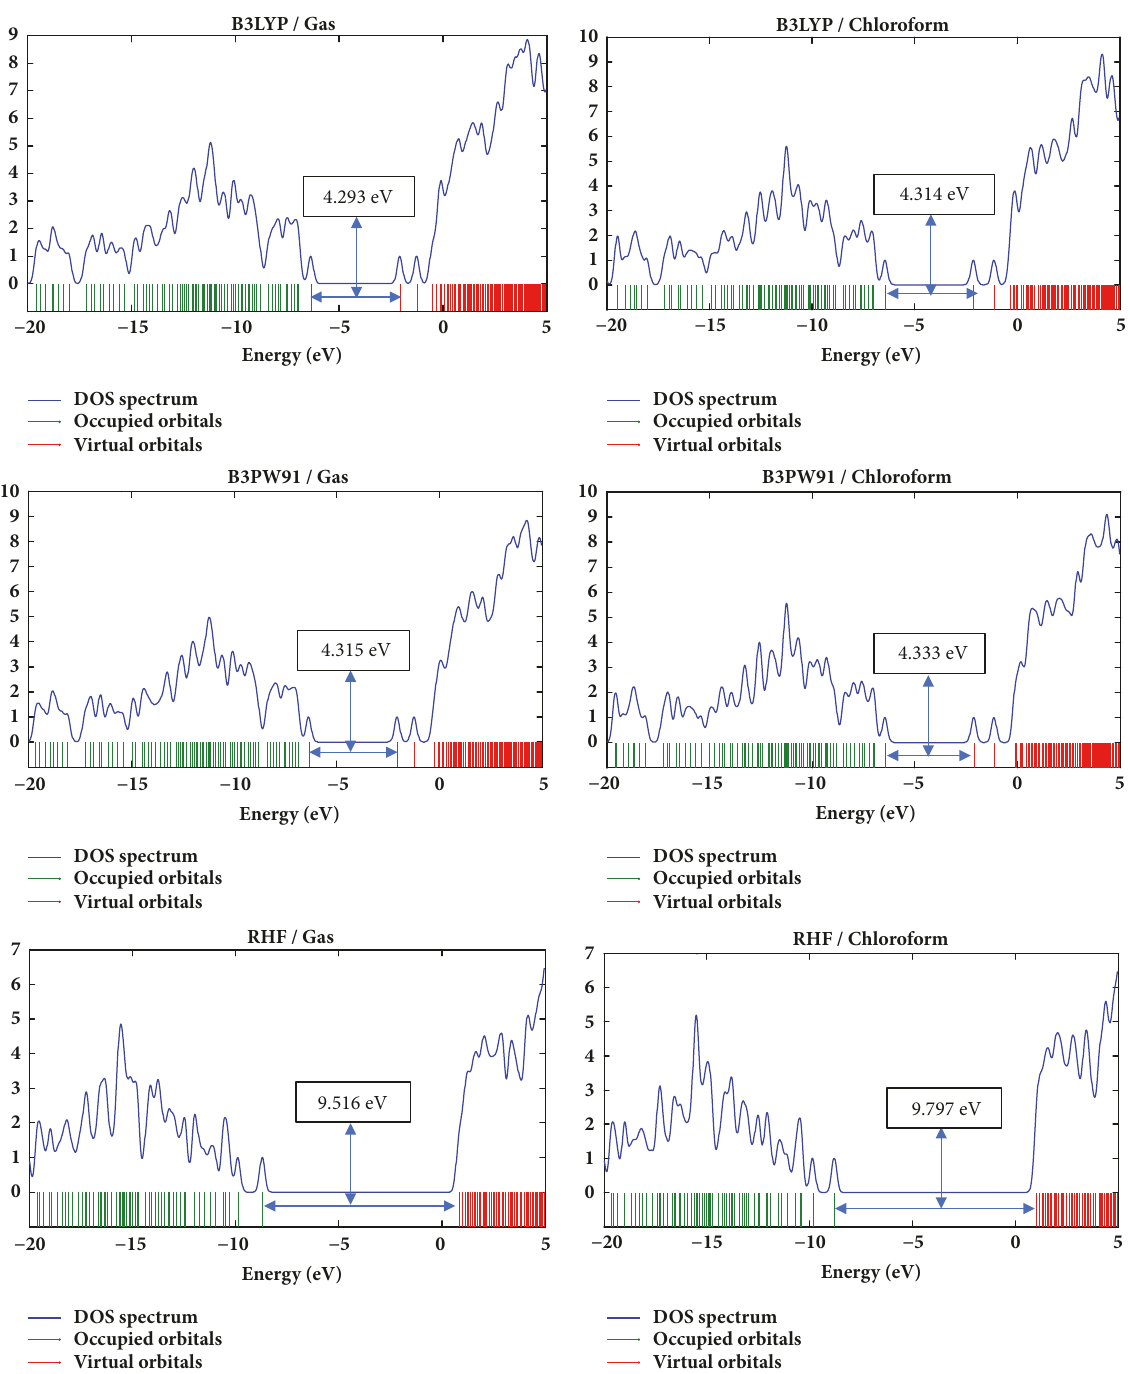
Figure 4: Total density of state (DOS) spectrum of Rubescin E at the RHF, B3PW91, and B3LYP levels in both gas and chloroform phase and with the 6-311++G(d,p) basis